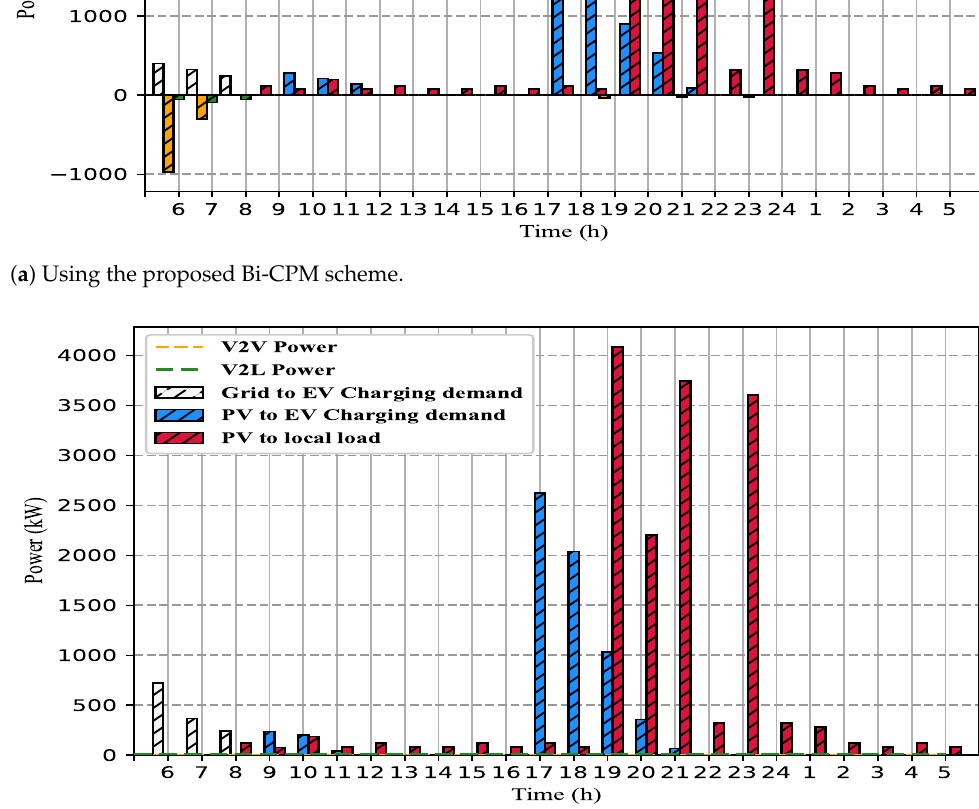
Figure 9. Obtained profiles in case